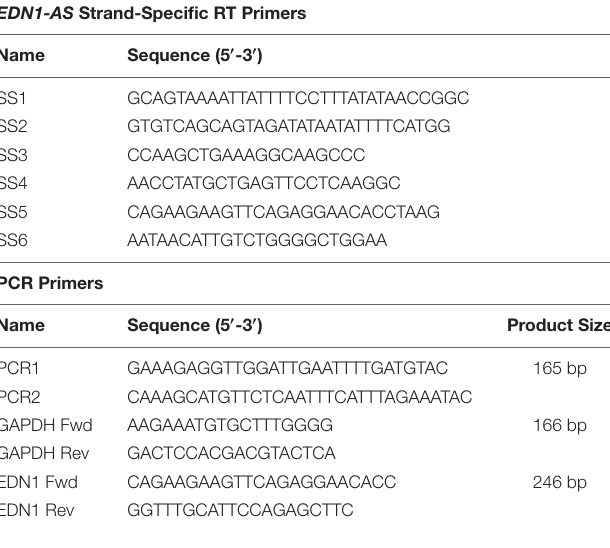
TABLE 1 | EDN1-AS Strand-Specific RT-PCR primers and